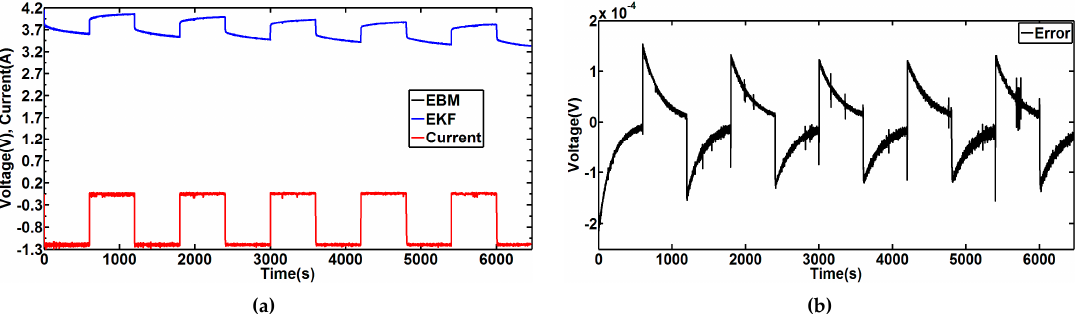
Figure 12. Extended battery model (EBM) and extended Kalman filter (EKF) voltages for 1.2 A current profile ( a ) voltages and current, ( b ) voltage error.